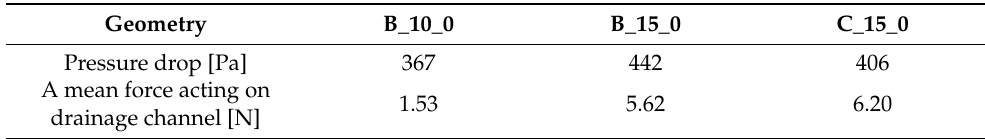
Table 16. Pressure drops on mist eliminators and the mean force acting on drainage the channel; inlet velocity 4 m s − 1